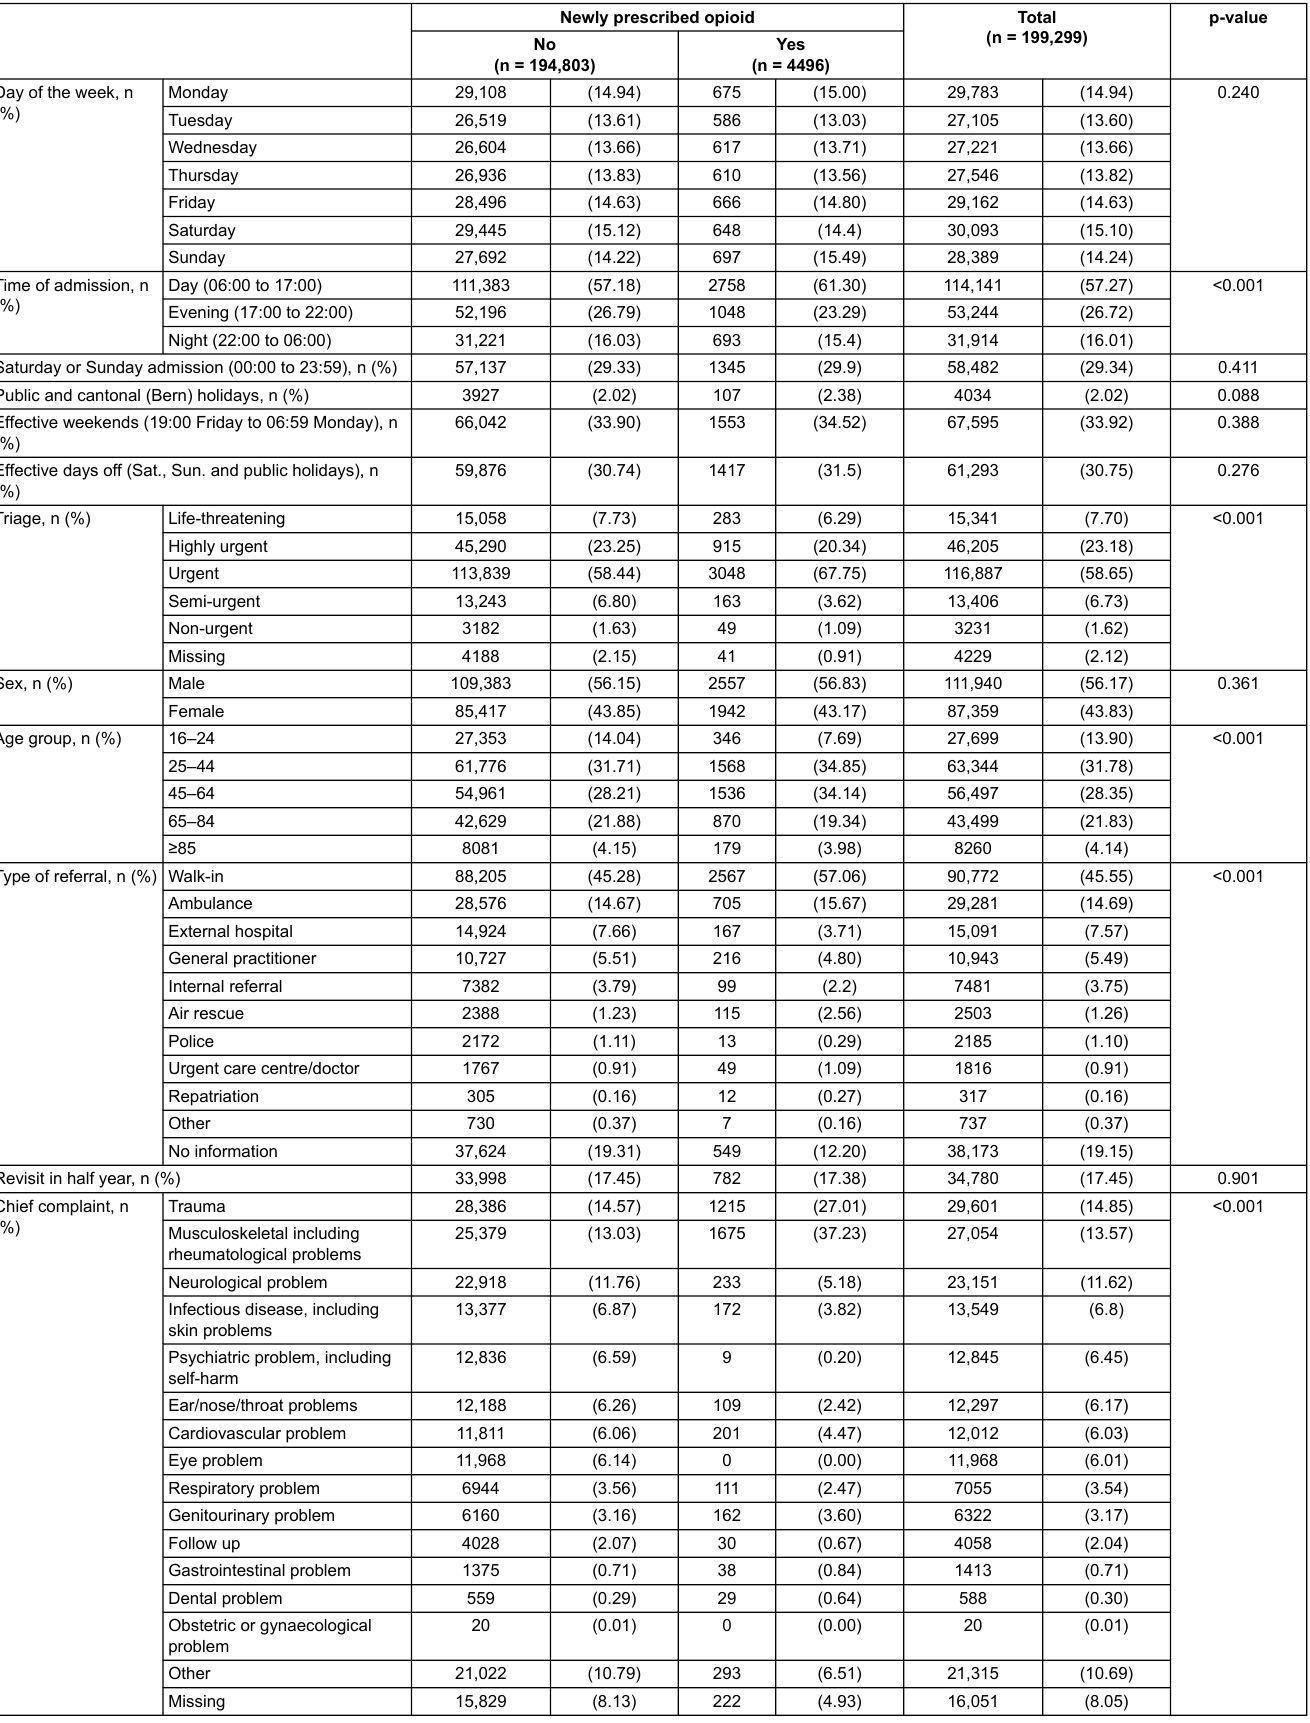
Table 1: Patient characteristics according to incident opioid use (n =